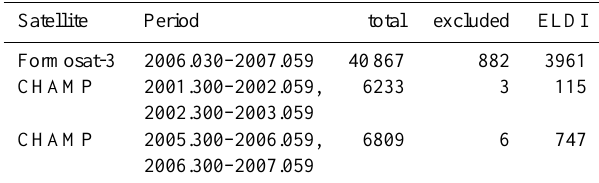
Table 1. Statistics of the profile recognition algorithm. We have used CHAMP and Formosat-3/COSMIC electron density profiles in the Northern Hemisphere in north winter, i.e. doy > 330 or doy < 60, and latitude > 45 ◦ N. The total number of available profiles, the number of bad profiles which were excluded from the analysis, and the number of profiles with ELDI signature are shown. Satellite Period